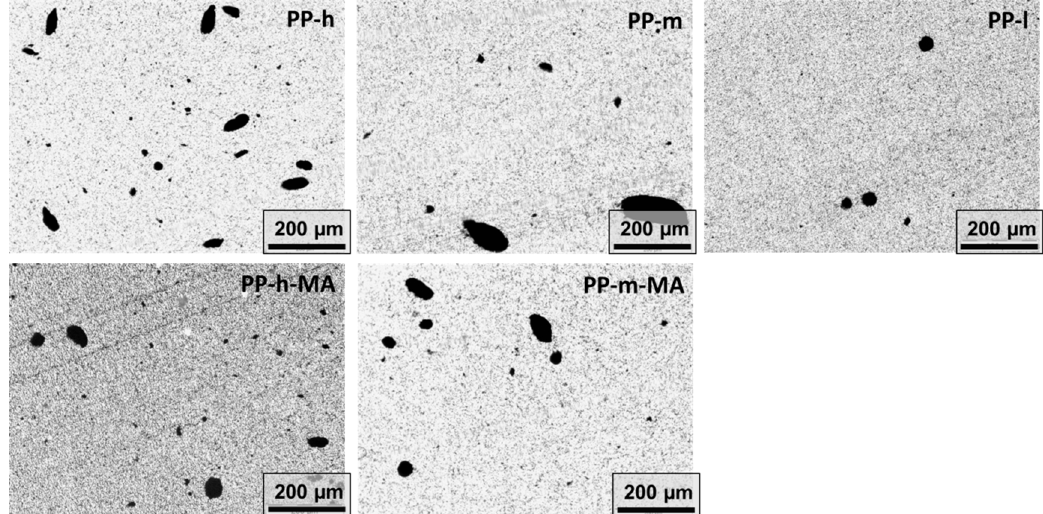
Figure 2. State of macro dispersion as observed by light microscopy for polypropylene (PP)/2 wt % multiwalled carbon nanotubes (MWCNT) composites.